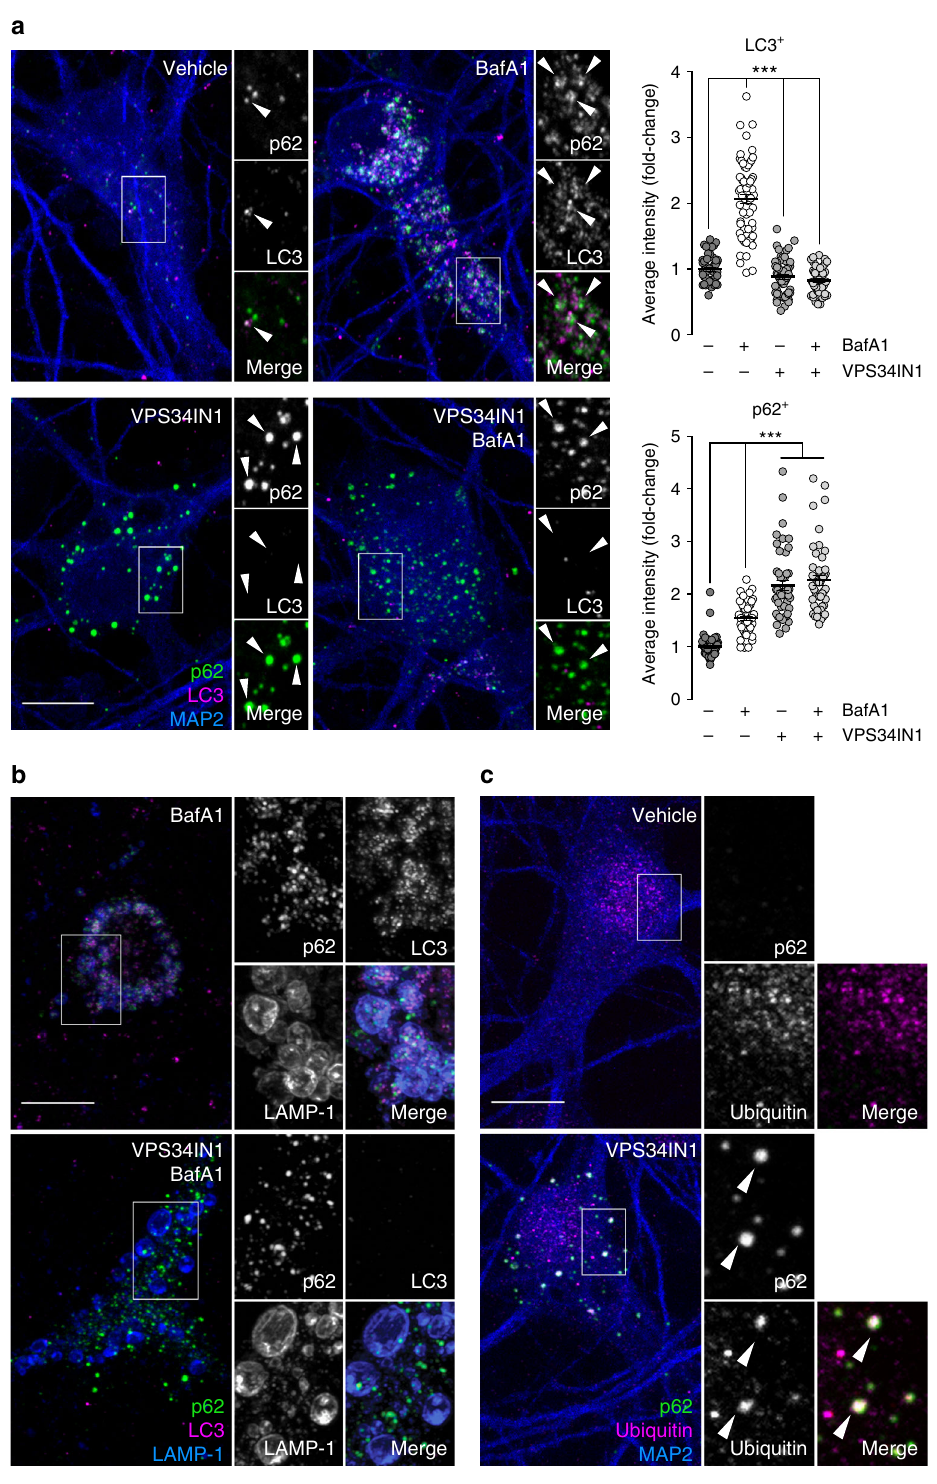
Fig. 2 Vps34 inhibition blocks autophagy initiation and causes accumulation of ubiquitin-positive and p62-positive structures. a Representative confocal images of cortical neurons treated with vehicle, Ba fi lomycin A1 (BafA1) at 50 nM, VPS34IN1 at 3 µ M or cotreated for 3 h. Arrows highlight LC3 and p62 structures. Right panel, bar graphs denote average object intensity, per cell (mean ± SEM, N = 49-60 cells, from three independent experiments). Scale bar, 10 µ m. *** p < 0.001 in one-way ANOVA, Holm – Sidak ’ s multiple comparisons test. b Representative confocal images of cortical neurons treated as in a and immunostained for LAMP-1, LC3, and p62. Airyscan insets highlight position of LC3 and p62 structures relative to LAMP-1-positive membranes. Scale bar, 10 µ m. c Representative confocal images of cultured cortical neurons treated with vehicle or VPS34IN1 at 3 µ M for 24 h. Arrows highlight p62 and ubiquitin colocalization. Scale bar, 10 µ